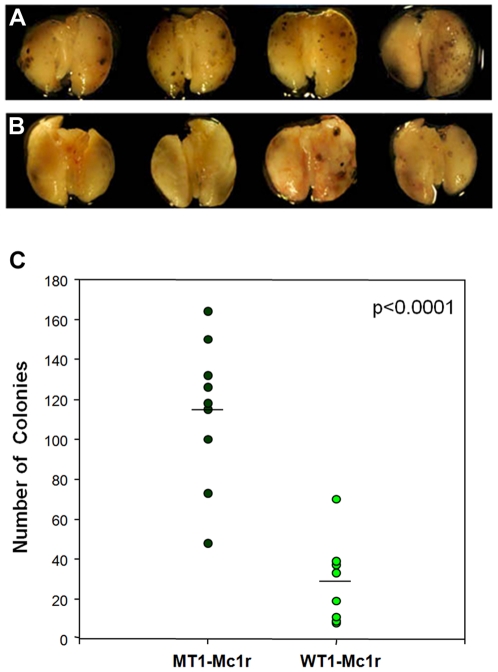
Confirmation of the role of Mc1r on cell migration using an in vivo metastasis model.(A, B) Effect of Mc1r knockdown on the development of pulmonary metastatic colony was determined. B16F10 melanoma cells were treated with MT1-Mc1r (A) or WT1-Mc1r (B) and injected into tail vein of C57BL/6 mice. Representative lungs harvested after 18 days are shown. (C) B16F10 colonies visible on the lung surface were counted and plotted. N = 9 for MT1-Mc1r and N = 8 for WT1-Mc1r. The significance of difference (p<0.0001) was determined by t-test.